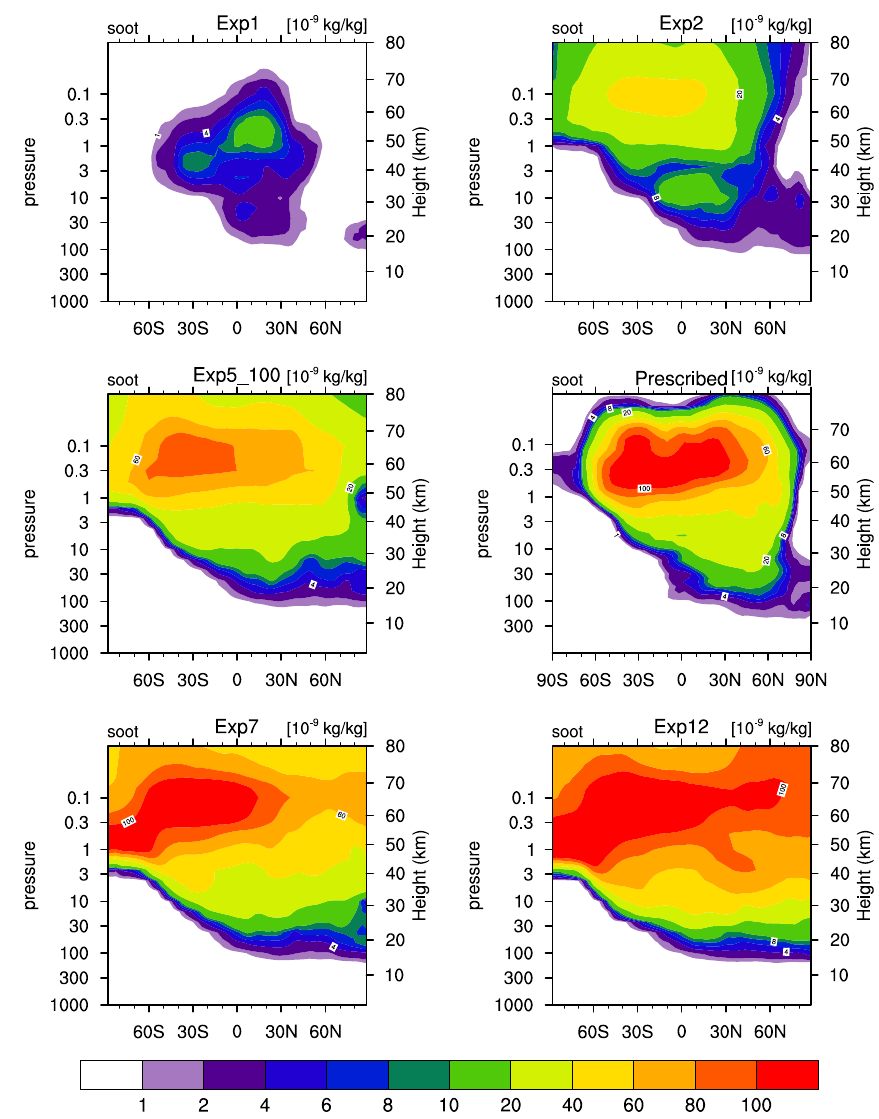
Fig. 2. Vertical soot distributions 15 days after the emission for various scenarios (Exp1, Exp2, Prescribed, Exp5_100, Exp7, Exp12). The distributions show the zonally averaged soot mass mixing ratio [10 − 9 kgkg − 1 ] as function of latitude and